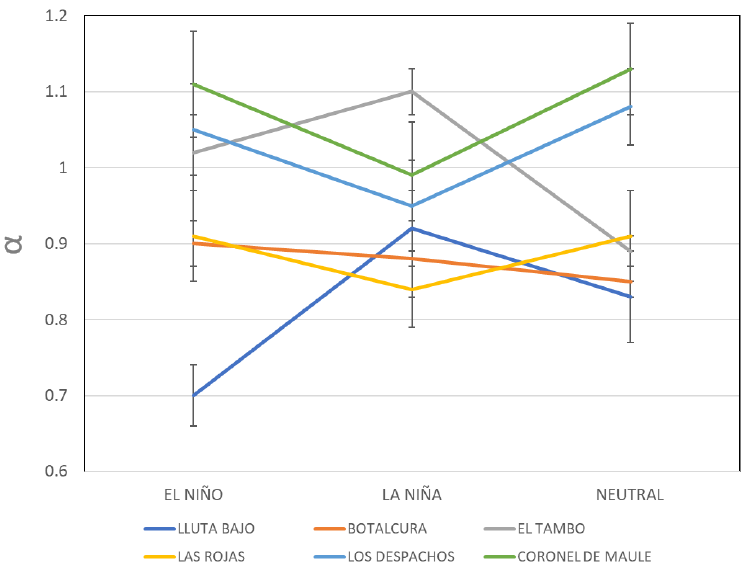
Figure 4. Chilean solar radiation range for a time scale window greater than ten days. The error bar represents one standard error of the Detrended Fluctuation Analysis (DFA)